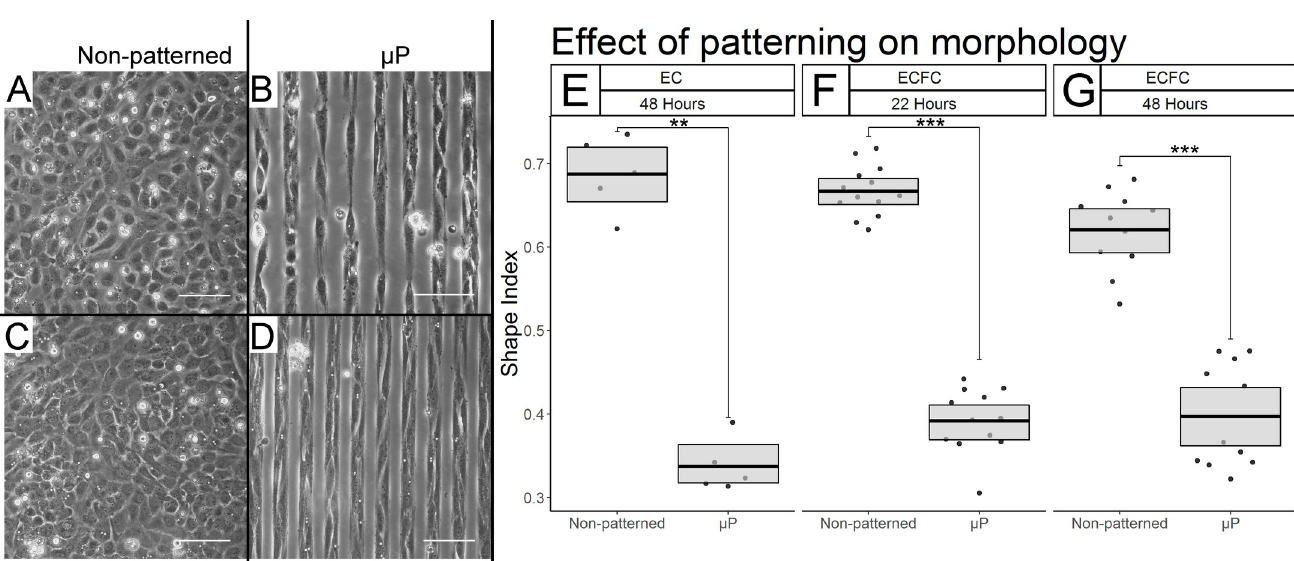
PLOS ONE | https://doi.org/10.1371/journal.pone.0218197 June 12,